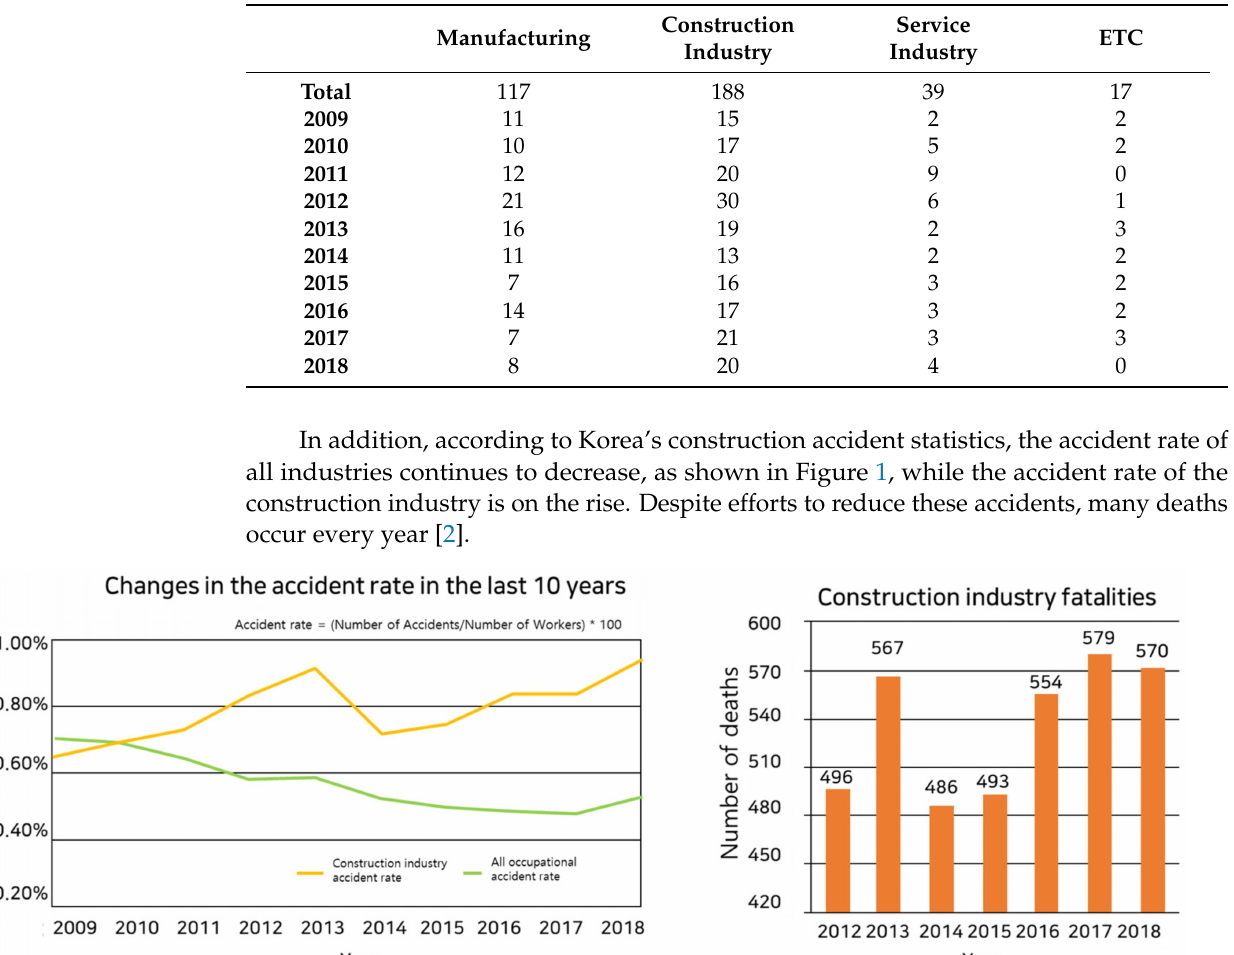
Table 1. Major accidents by year.